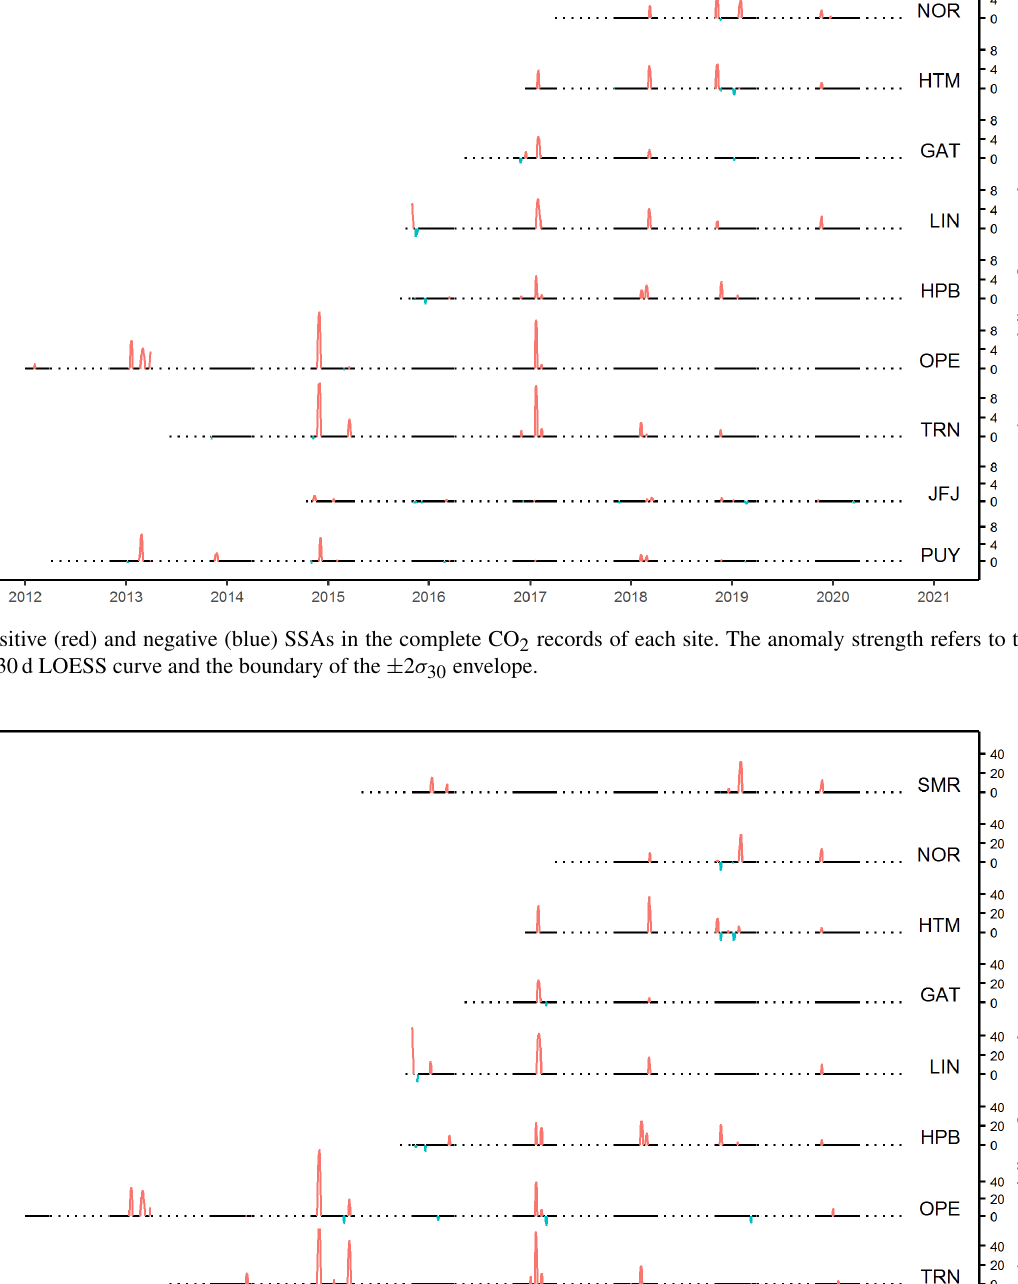
Atmos. Meas. Tech., 14, 6119–6135,